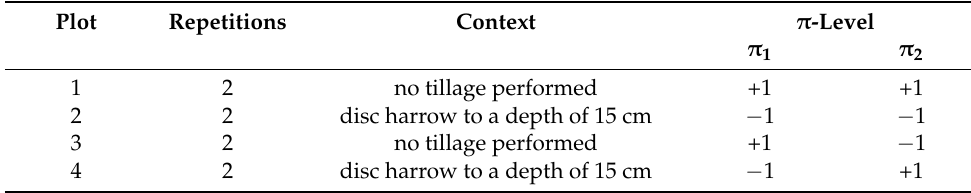
Table 3. Plan summary of test performed in March.